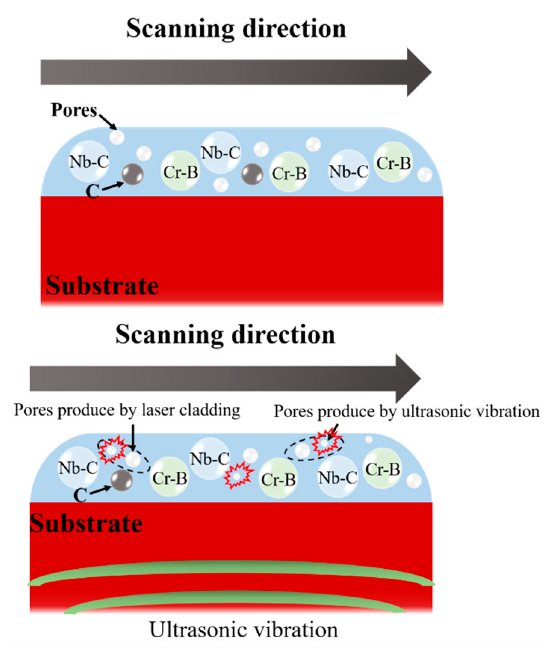
Figure 10. Mechanism of pore elimination [27].